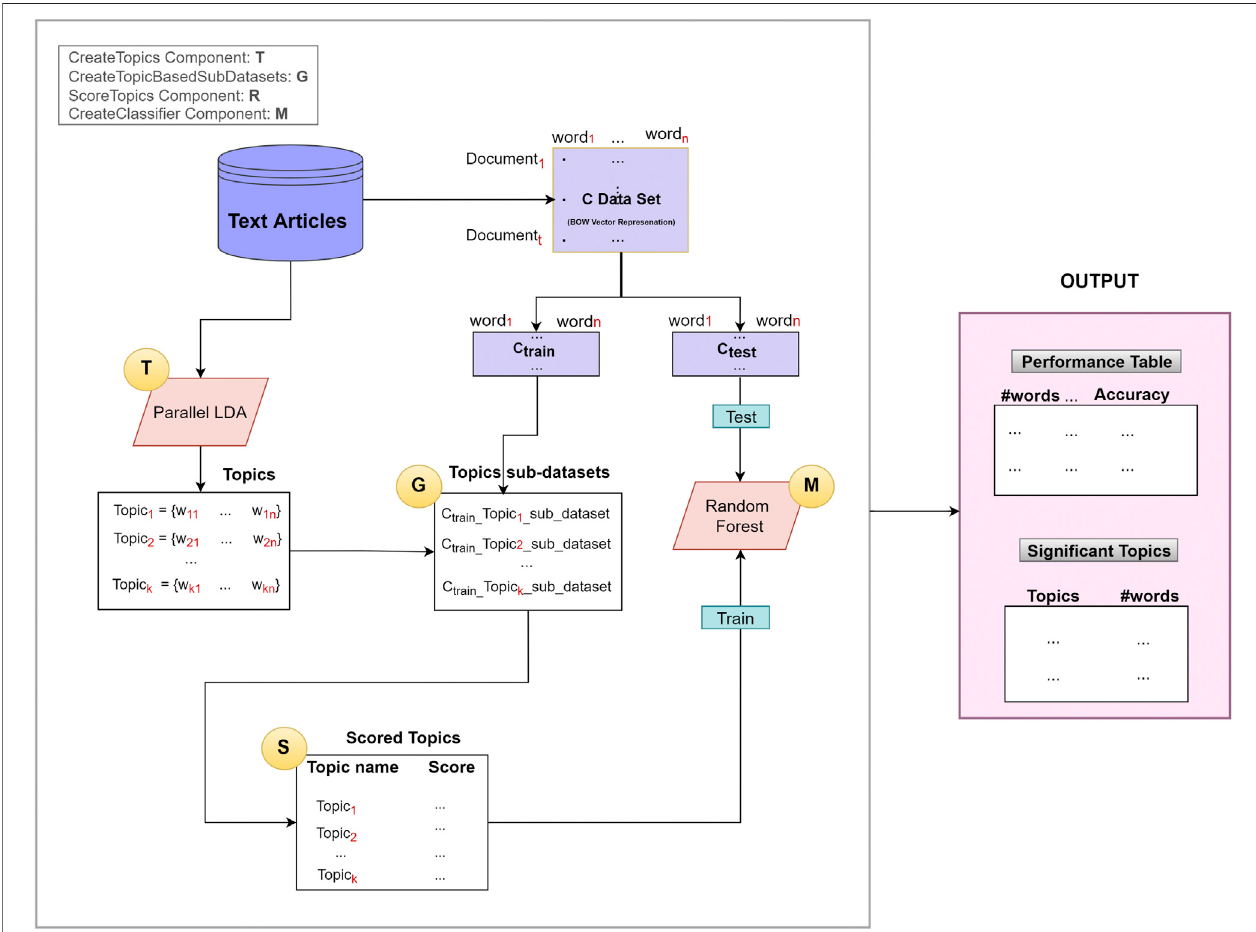
FIGURE 2 | The TextNetTopics general approach is based on four main components: T for creating topics, G for generating topic-based sub-datasets, S for scoring/ranking topics, and M for creating and evaluating the model.